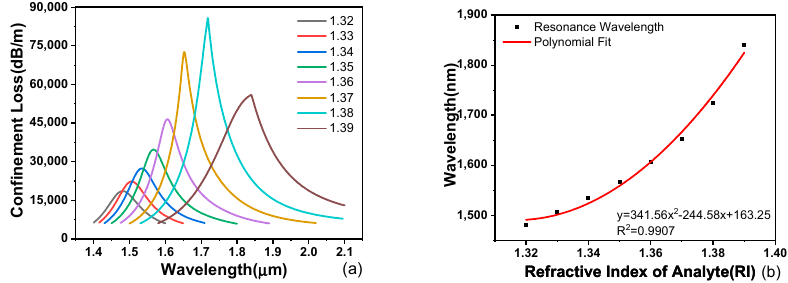
Figure 8. The loss spectra ( a ) and resonance wavelength ( b ) for various analyte’s RI. Table 1. Sensing performance of the MPF–SPR sensor. Analyte RI. Resonance Wavelength (nm)